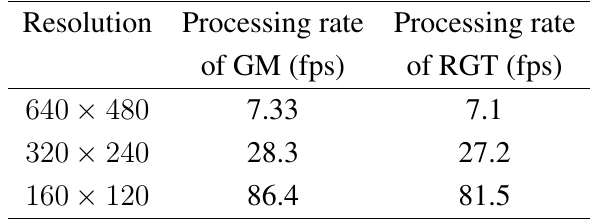
Table 5. Processing rate (fps) of various background subtraction methods for different image